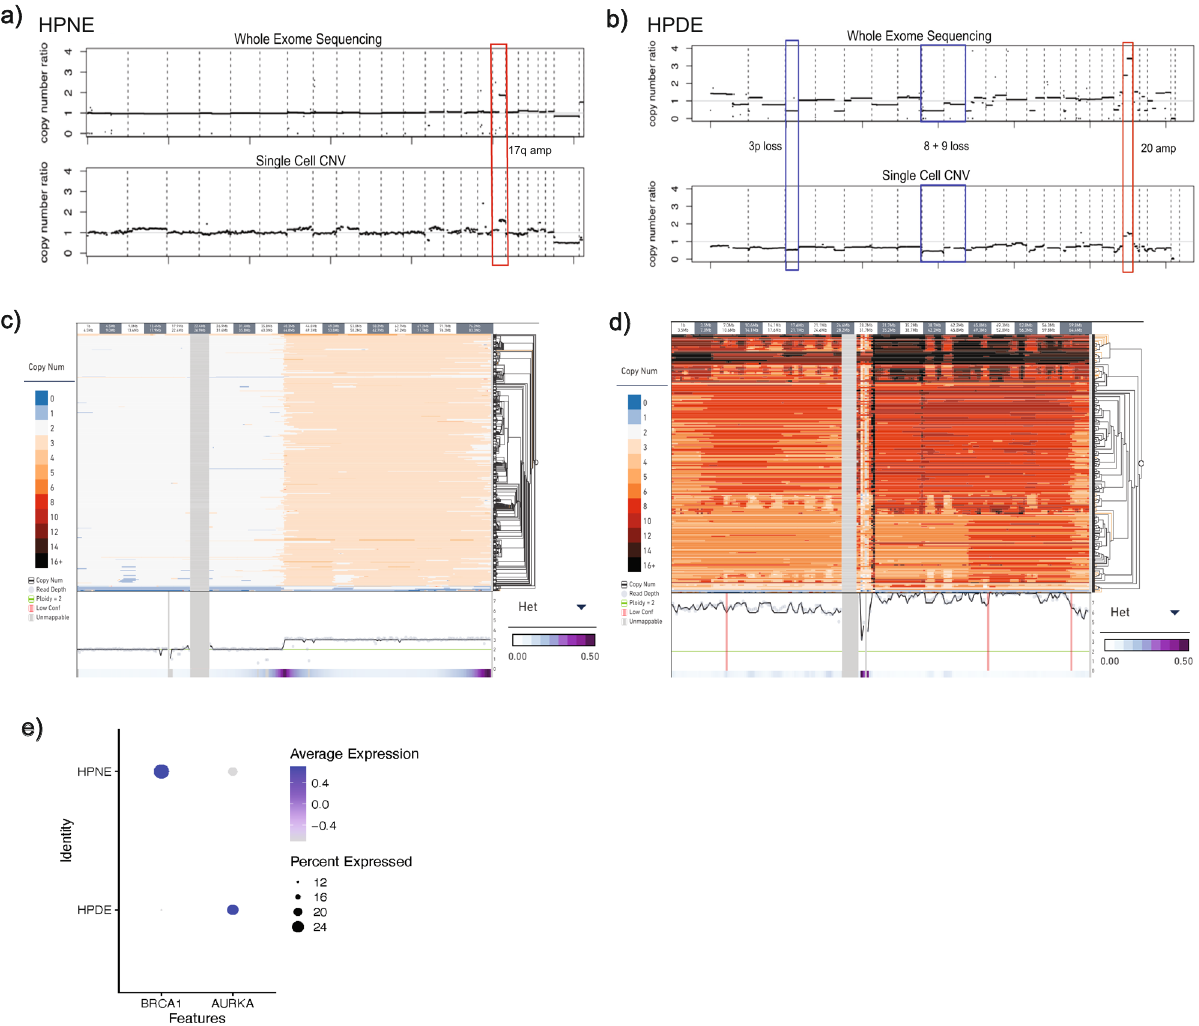
Fig. 2 Genomic characterization of HPDE and HPNE normal control cell lines. a scCNV comparison to WES of HPNE cell line depicting ampli fi ed 17q as the only notable CNV event. b scCNV comparison to WES of HPDE cell line. CNV events representing losses of chromosomal arms 3p, 8p, and 9p and ampli fi cations at chromosome 20. c scCNV high-resolution cell phylogeny of HPNE for all chromosome 17 locations showing ploidy = 3 for all cells at 17q arm, region inclusive of BRCA1 loci. Columns indicate chromosomal intervals measured in Mb, rows indicate individual cells. Chromosomal regions depicted (labeled along top x-axis) are representative of CNV segments outlined in red in Fig. 1d. d scCNV high-resolution cell phylogeny of HPDE for all chromosome 20 locations showing ploidy >3 (as high as 13 in some cells at some locations) for all cells. Columns indicate chromosomal intervals measured in Mb, rows indicate individual cells. Chromosomal regions depicted (labeled along top x-axis) are representative of CNV segments outlined in red in Fig. 1e. Corresponding scRNA data shows elevated expression of AURKA, located within ampli fi ed HPDE region as a potential target of ampli fi cation. e scRNAseq data of HPNE and HPDE cell lines shows elevated expression of BRCA1 in >20% of HPNE cells, increased AUKRA expression in >20% of HPDE